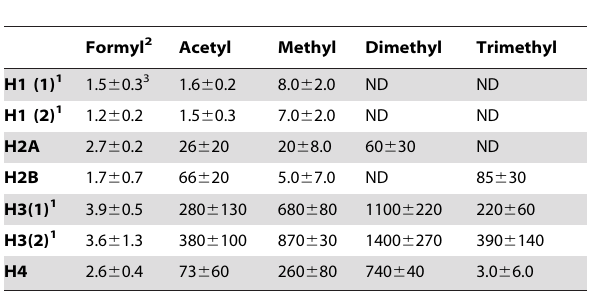
Table 1. Quantification of lysine modifications in HPLC- purified histone proteins. 1